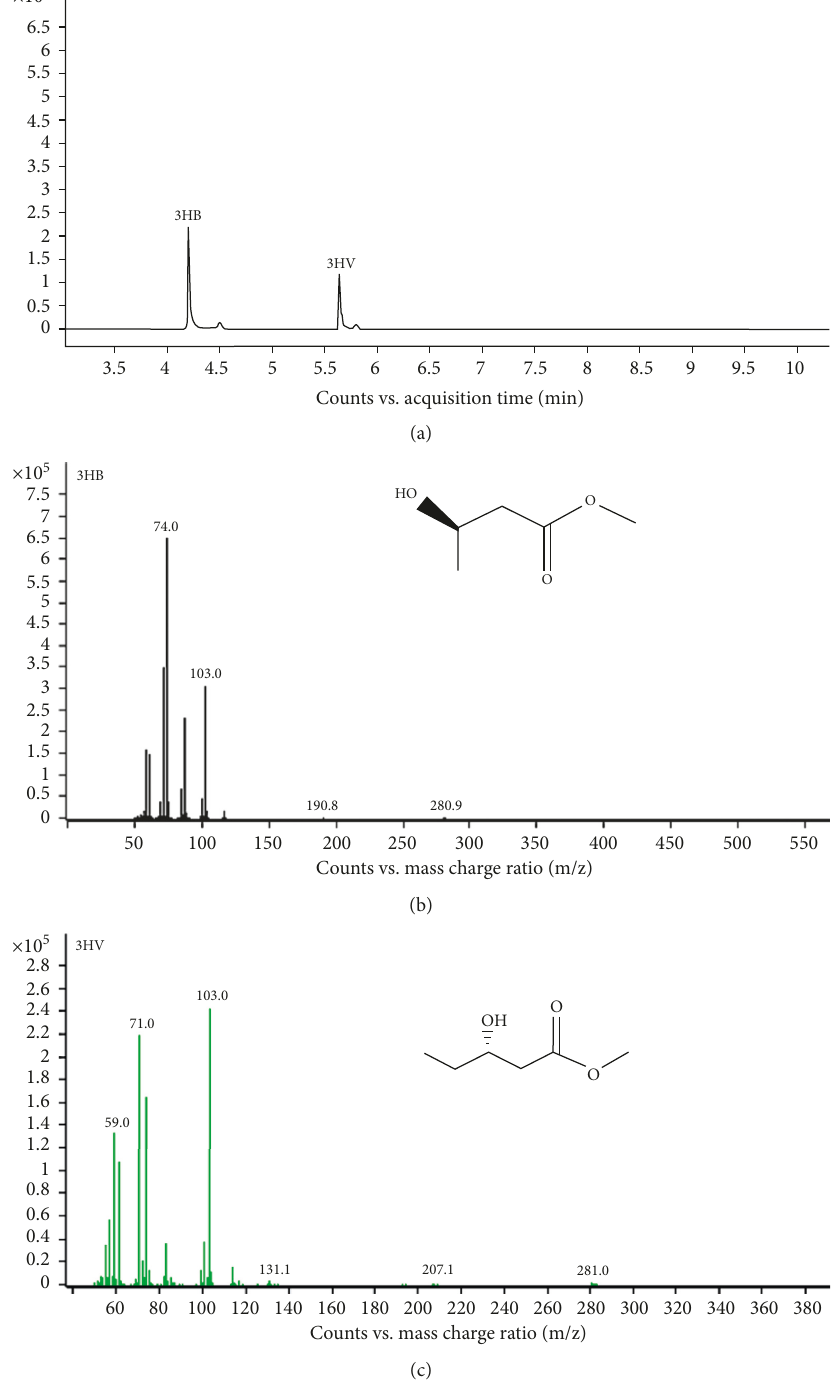
Figure 1: Composition analysis of purified PHA-extracted material from R. rubrum (ATCC 11170) by